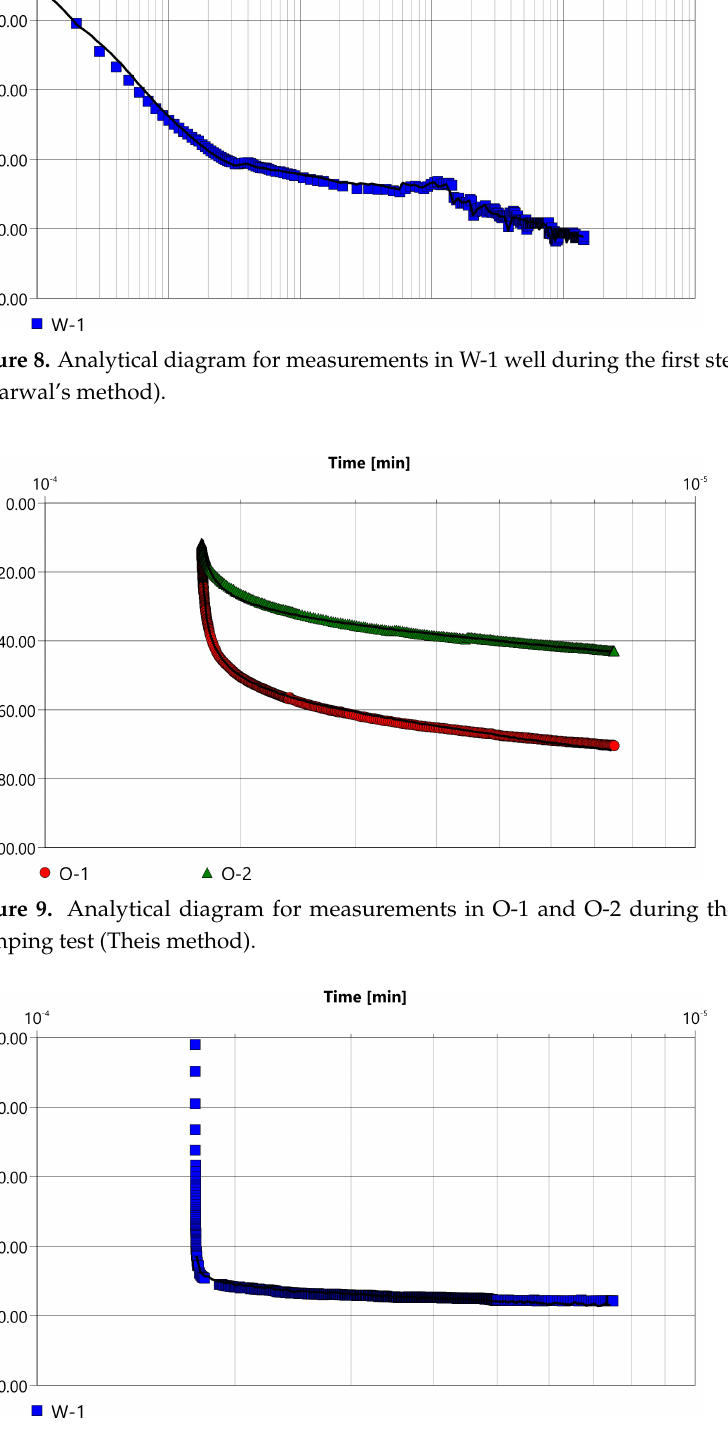
Figure 10. Analytical diagram for measurements in W-1 well during the second step of the pumping test (Agarwal’s